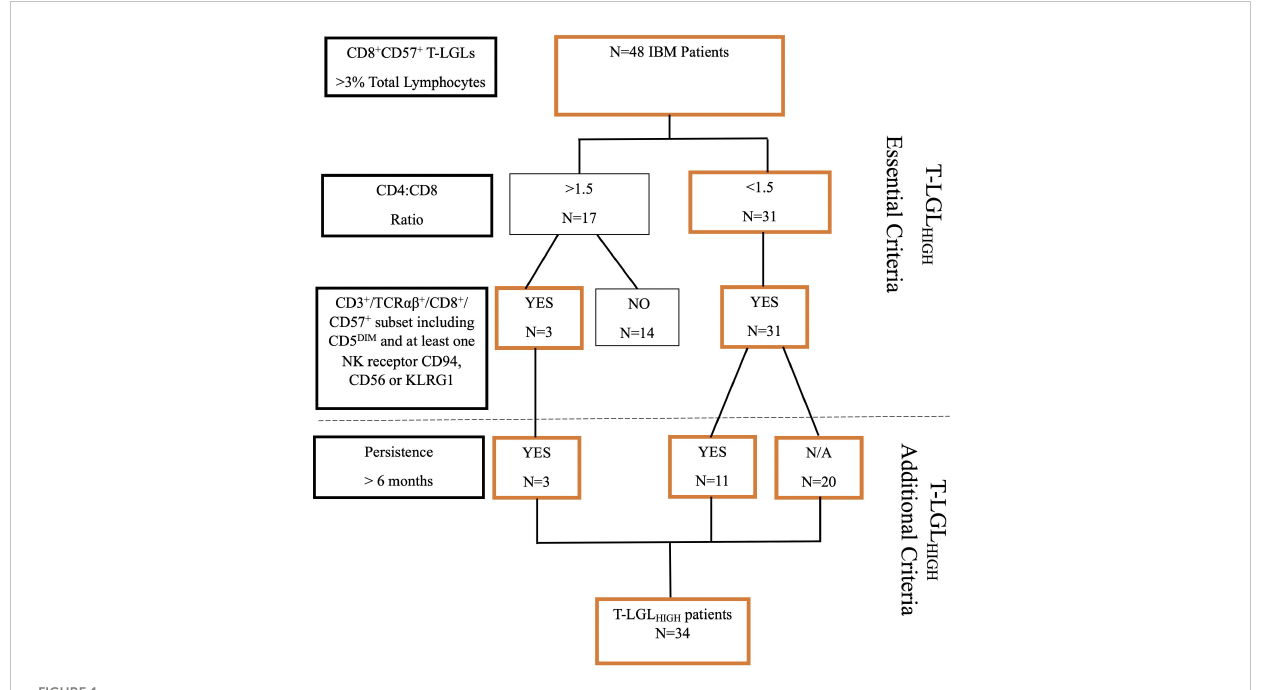
FIGURE 1 Flowchart of selection criteria for T-LGL HIGH